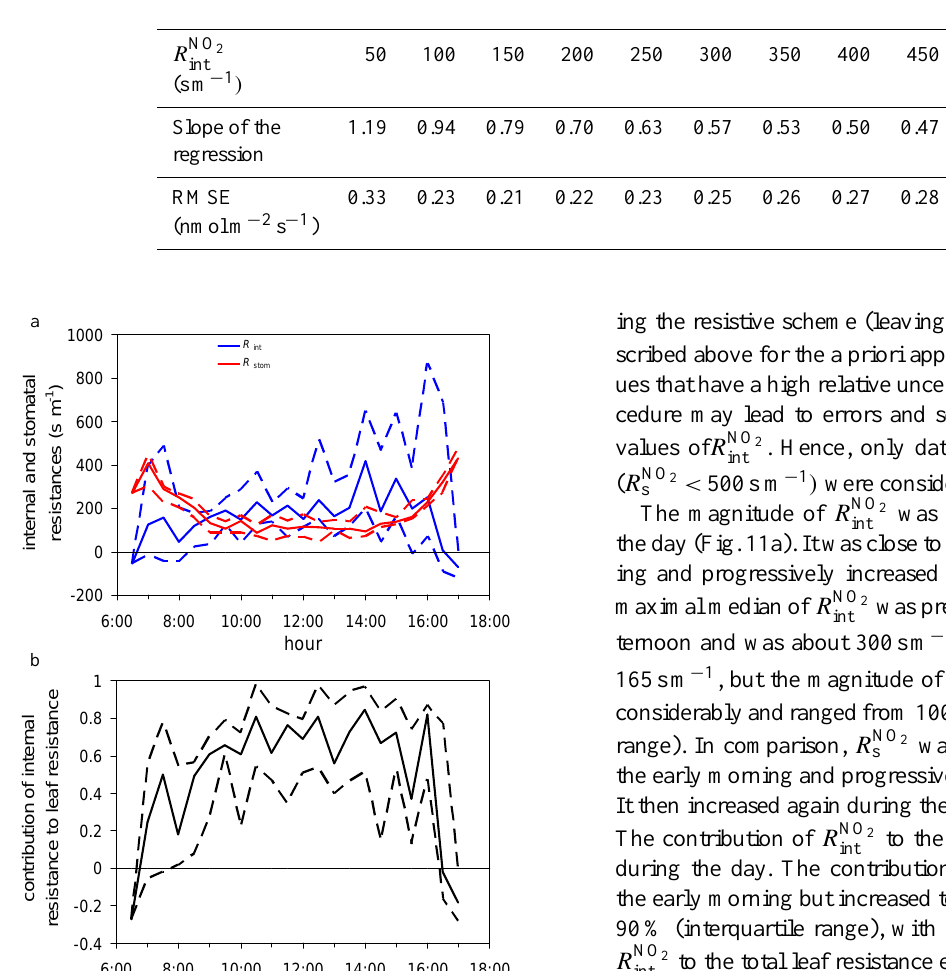
Table 2. Comparison of measured and modelled NO 2 fluxes for different values of the internal resistance. Only data for 1 /R NO 2 s > 0 . 2cms − 1 ( R NO 2 s < 500sm − 1 ) were included.